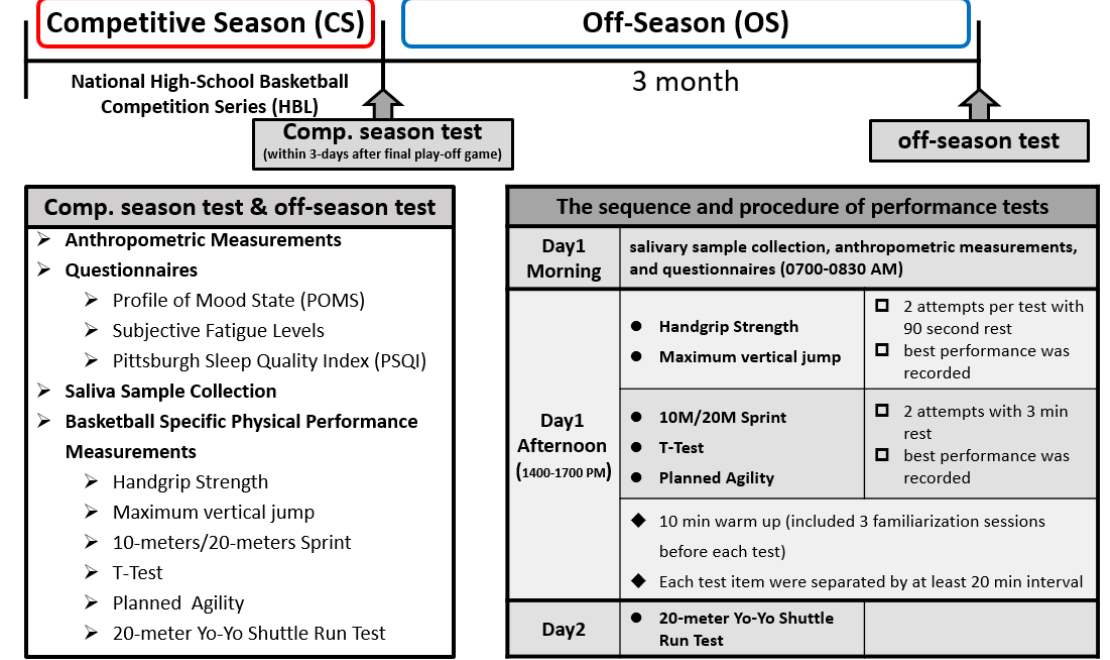
Figure 1. Diagram depicting measurement procedures for the competitive season and off-season. Table 2. Training programs for the competitive season and off-season.